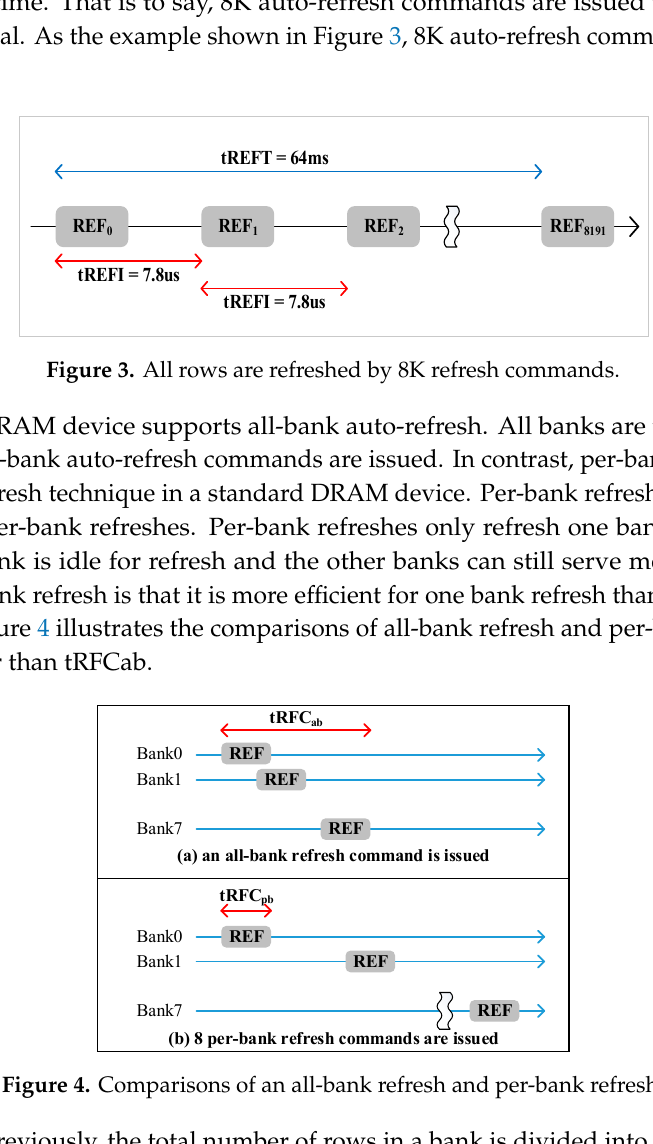
Figure 5. Illustrations of ( a ) 1x and ( b ) 2x auto-refresh. 3. Motivation and Example In a DRAM refresh, a refresh command includes 8192 refresh times in 64 ms of a refresh interval. Although RAAR reduces a large number of unnecessary refreshes, some banks that do not contain weak rows still have to be refreshed because of all-bank refresh mode. Also, although 2x granularity reduces refresh interval to one half of that in 1x granularity, its refresh cycle time exceeds one half of that in 1x granularity. For example of the 8 Gb DRAM, for 1x granularity its refresh interval is 7.8 us and refresh cycle time is 350 ns, and for 2x granularity its refresh interval is 3.9us and refresh cycle time is 260 ns. Two 2x granularity refresh requires 520 ns while one 1x granularity refresh only require 350 ns. Therefore, a retention-aware refresh scheme to corporate with 2x granularity refresh is necessary. For the RAAR technique proposed by research [4], only refresh bundles that contain weak rows need a refresh in each refresh interval. However, weak rows distribution between refresh bundles may differ dramatically. If the same refresh scheme is used all over the RAAR period, there still will be quite number of refresh time wasted due to extra normal cells refreshing or bad weak rows refreshing sequentially. For the example illustrated in Figure 6, we executed refresh commands with the same refresh scheme all over the refresh interval (refresh 8192 times in 64 ms). Figure 6a shows the results when